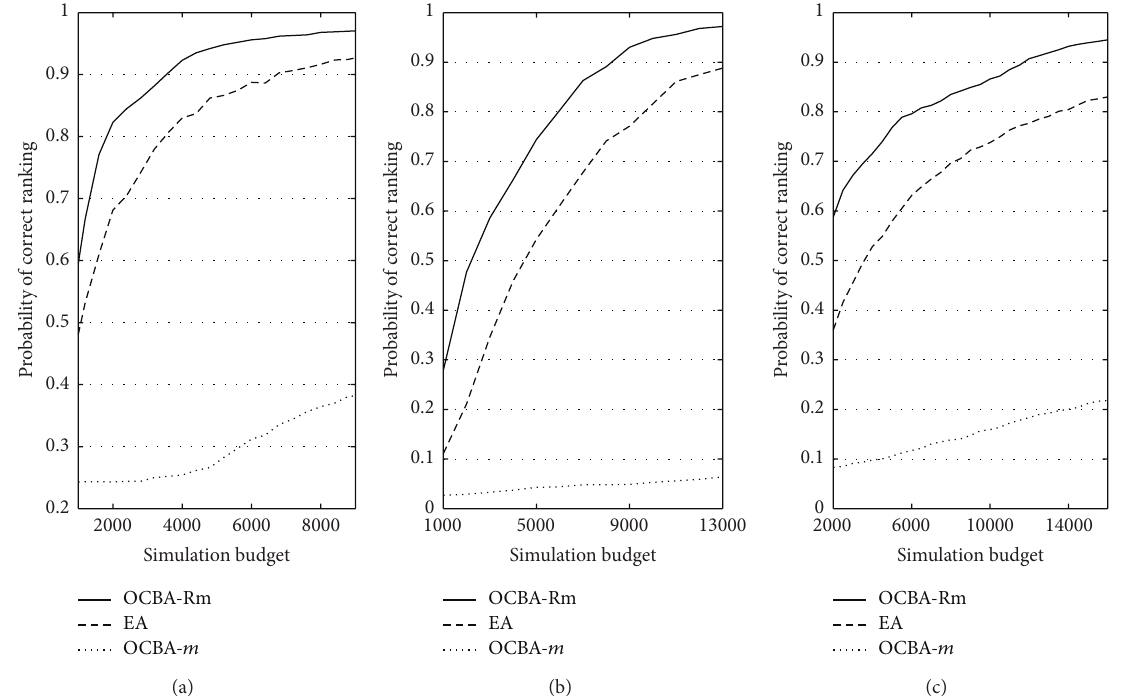
Figure 1: Probability of correctly ranking the top 𝑚 designs under three different allocation